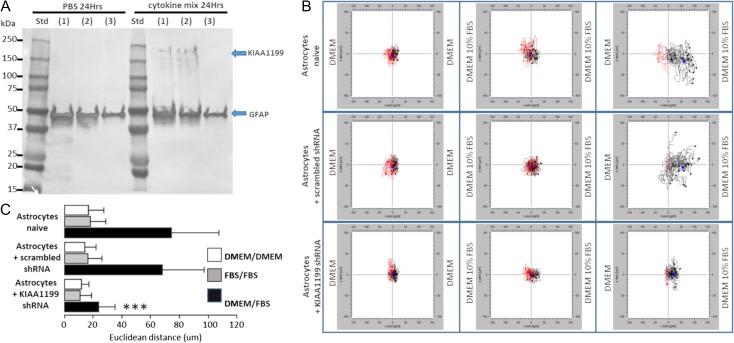
shRNA-silencing KIAA1199 expression reduces astrocyte migratory capacities through hyaluronan (HA)-rich environment. (A) In order to visualize KIAA1199 shRNA ability to prevent protein expression, primary mouse astrocytes were incubated or not with a cytokine mix (TNF-α, IL-1α and INF-γ) for 24 h. Expression of KIAA1199 protein from astrocyte cultures preinfected or not with KIAA1199 shRNA was assessed by western blot. (1) Naive astrocytes; (2) astrocytes infected with scrambled shRNA; (3) astrocytes infected with KIAA1199 shRNA. (B) Chemotaxis assays of astrocytes infected with shRNA. Astrocytes were embedded in the Hystem-C HA-rich gel and subjected or not to a 10% FBS gradient in a 3D chemotaxis chamber. Cell migration was recorded for 48 h and plotted. Astrocytes migrated toward medium containing 10% FBS. (C) Histogram showing the euclidean distance in micrometers migrated by the different astrocytes cultures (***P < 0.001, one-way ANOVA).